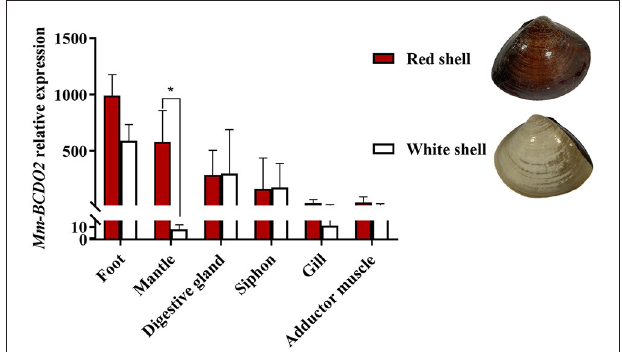
FIGURE 3 | Relative expression levels of Mm-BCDO2 in different tissues from M. meretrix . Significant differences between red shell and white shell are indicated with an asterisk for P < 0.05.